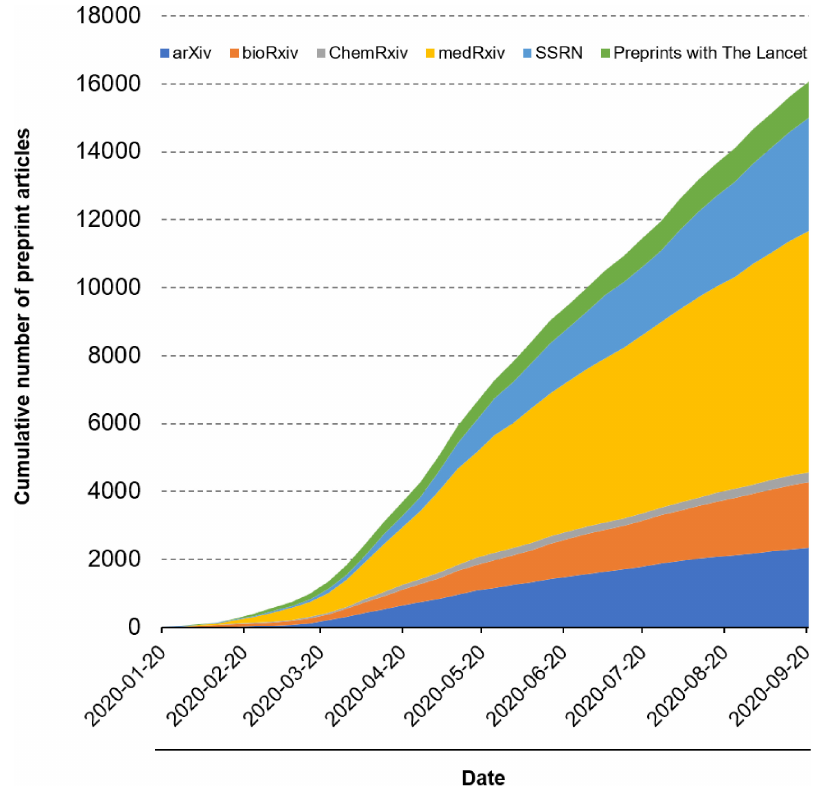
Figure 1. Preprint article publications on COVID-19 over time Cumulative graph showing the number of preprint articles about COVID-19 published on six preprint servers (arXiv, ChemRxiv, medRxiv, bioRxiv, Social Science Research Network (SSRN), and Preprints with The